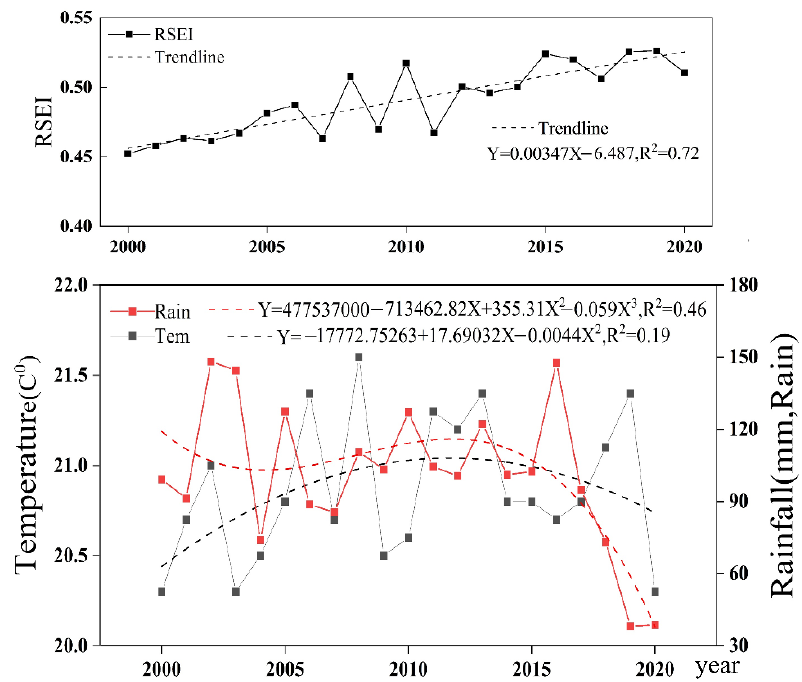
Figure 12. RSEI and temperature, rainfall mean change statistical chart. Table 4. Chart of correlation statistics of temperature, rainfall and RSEI.